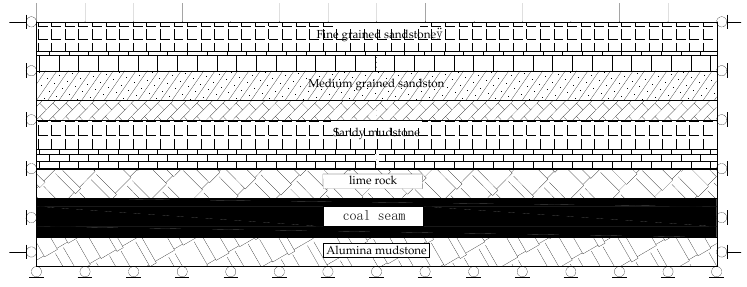
Figure 6. Mechanical model of numerical simulation.